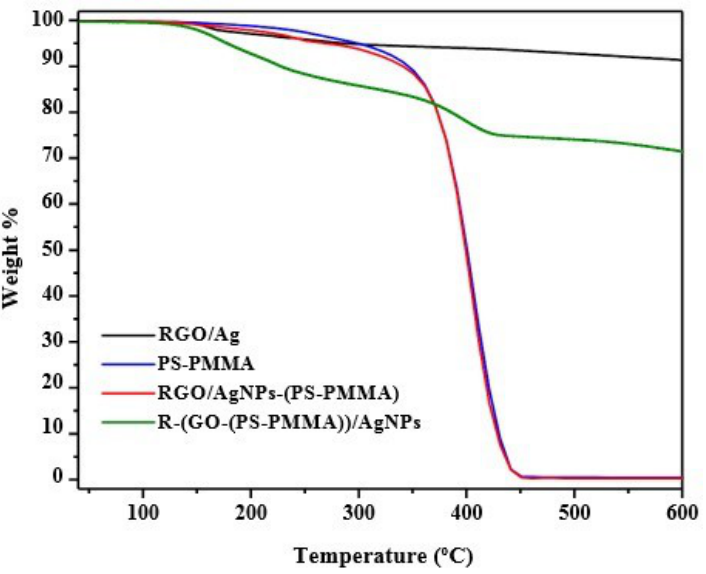
Figure 7. TGA thermograms for RGO / AgNPs / PS-PMMA nanocomposites.